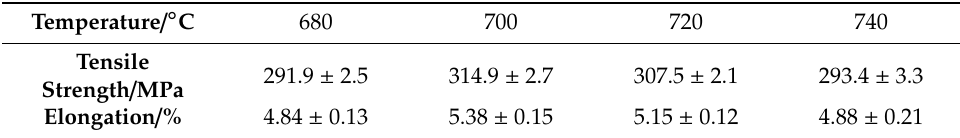
Table 3. Mechanical properties of vacuum counter-pressure casting aluminum alloy without UST.